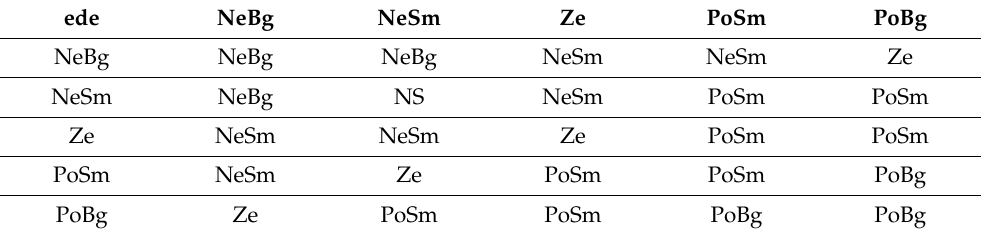
Table 5. Fuzzy rule foundation for CFPID.